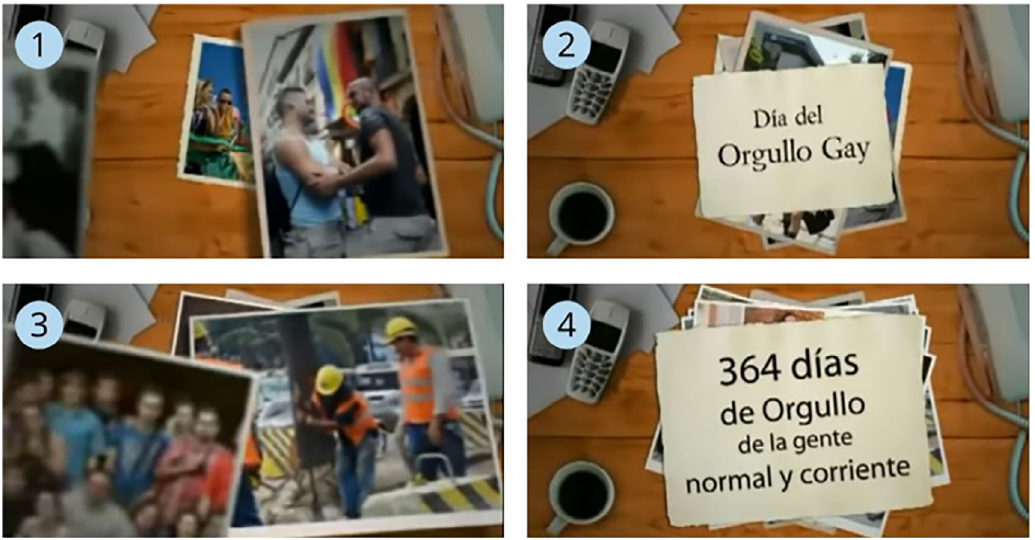
Figure4.SequenceofstillsfromcommercialNo.61,broadcaston IntereconomíaTV. Translatedtextfromthead: Image 2: Gay Pride Day; Image 4: 364 days of Pride for ordinary people.